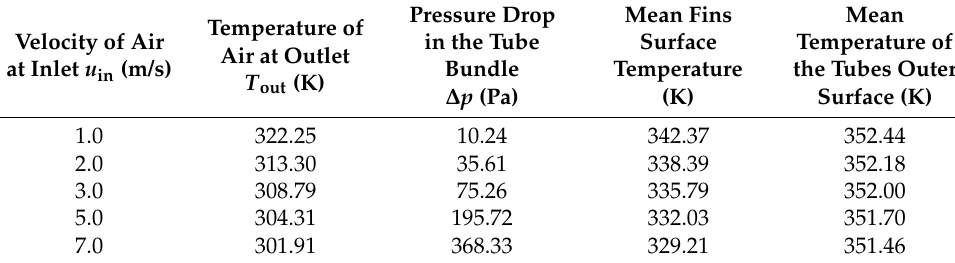
Table 4. Output data for the trimming diameter of 31 mm.